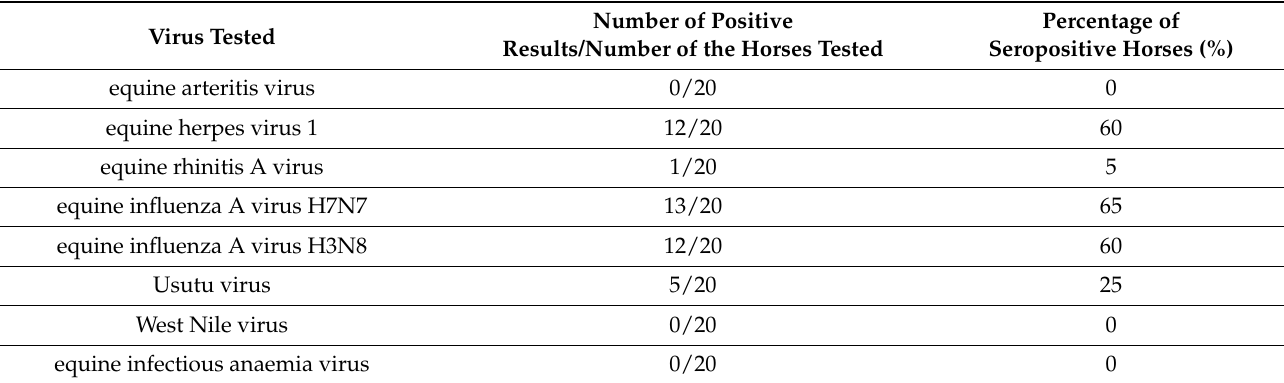
Table 1. Results of serological investigation of the Hucul herd.